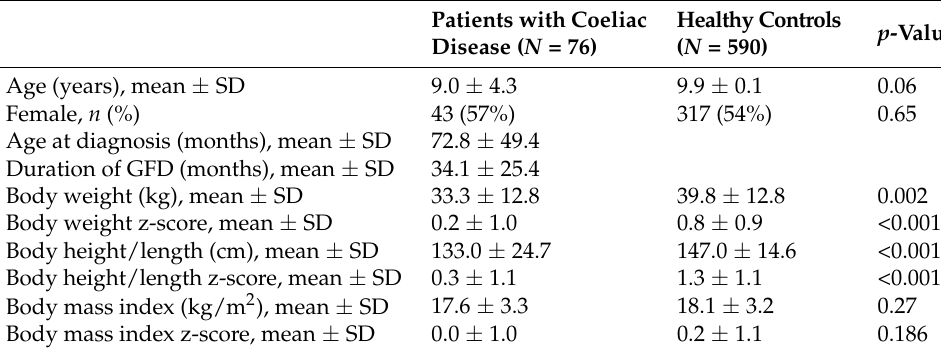
Table 1. General characteristics of study